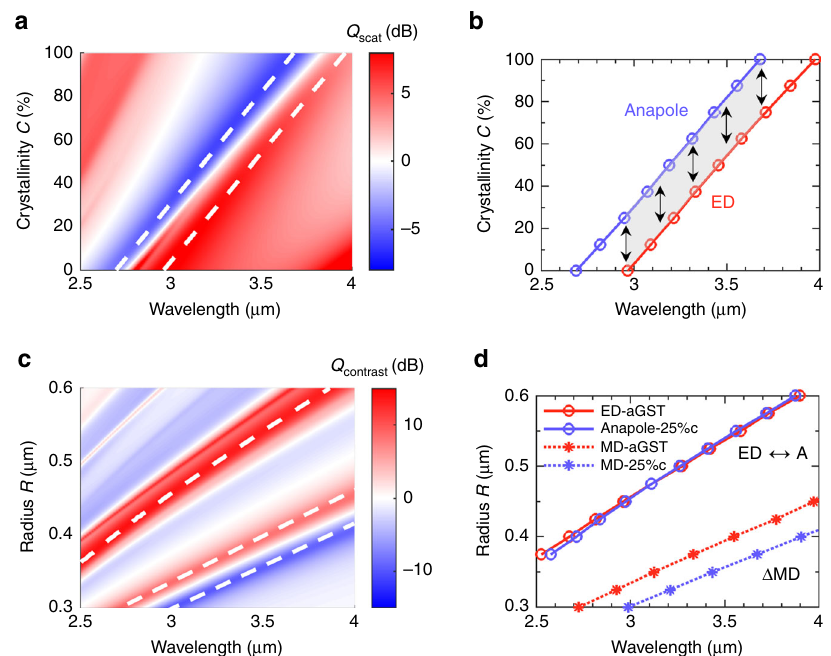
Fig. 2 Broadband tuning and shifting of the multipolar scattering states in GST spheres. a Scattering ef fi ciency Q scat of a single GST sphere with a fi xed radius R = 450 nm and varying crystallinities C . Two white dashed lines indicate the scattering maxima and minima corresponding to the ED and anapole states. b Analytically solved ED and anapole conditions. Shifting between these two states can be realized within an ultrabroad bandwidth over 700 nm (the gray shaded area) by exploiting the intermediate levels of GST spheres. c Scattering cross-sectional contrast between aGST and 25%-cGST spheres with varying radii R . Three white dashed lines show the most noticeable scattering contrasts. d Analytically solved MD, ED, and anapole conditions to account for the scattering contrast between the aGST and 25%c-GST spheres. The ED and anapole positions are almost perfectly overlapped in a wavelength range spanning around 1.5 μ